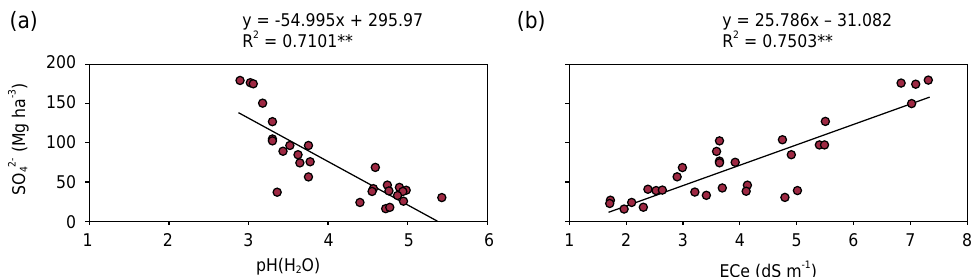
Figure 7. Relations between soluble sulfate (SO 42- ) and pH(H 2 O) and electrical conductivity of saturated soil-paste extract (ECe).